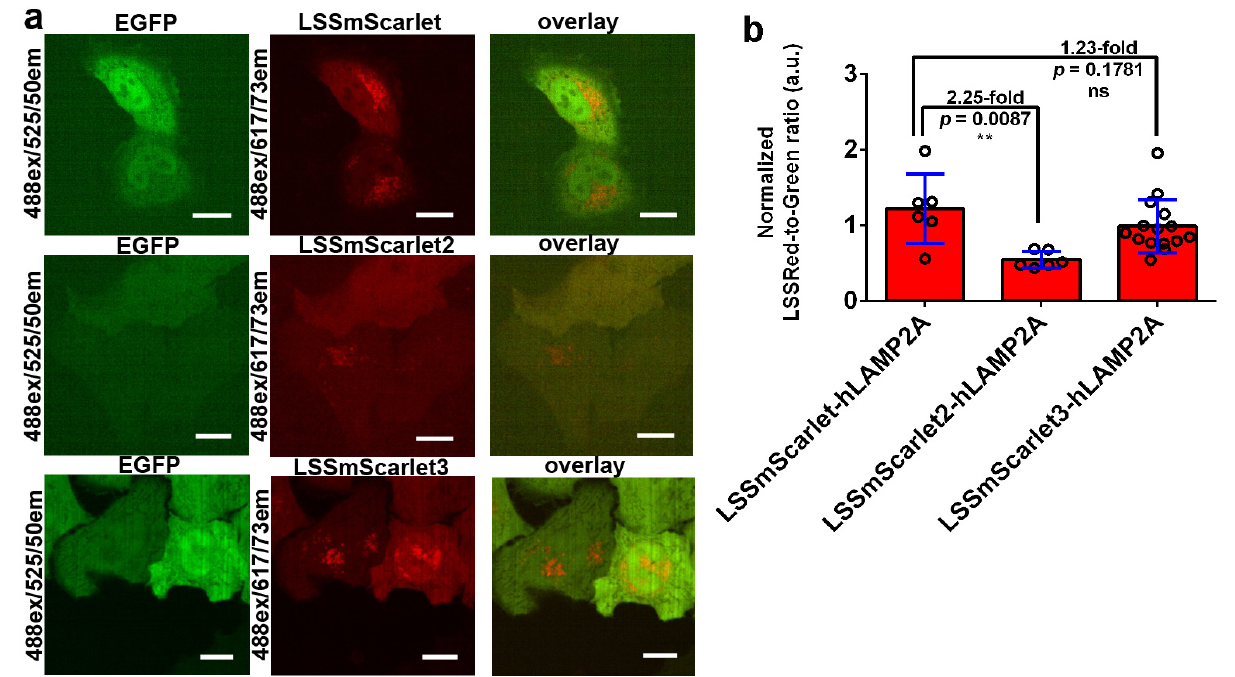
Figure 9. Comparison of the brightness of the LSSRFPs in fusions with hLAMP2A inside the lysosomal lumen of HeLa cells. ( a ) Confocal images of HeLa cells coexpressing EGFP with the LSSmScarlet-hLAMP2A, LSSmScarlet2-hLAMP2A, or LSSmScarlet3-hLAMP2A LSSRFPs. LSSRed (488 ex and 617/73 em, in red color) and green (488 ex and 525/50 em, in green color) fluorescence channels and their overlay are shown. Scale bar, 50 µm. ( b ) The averaged brightness for the LSSRFPs in lysosomes of HeLa cells normalized to the brightness of the EGFP expressed in cytosol of the same cells. The error bars are standard deviations of 6–15 cells. The p values show the significant differences between the respective values. ns, not significant, p value > 0.05. **, p value < 0.01.